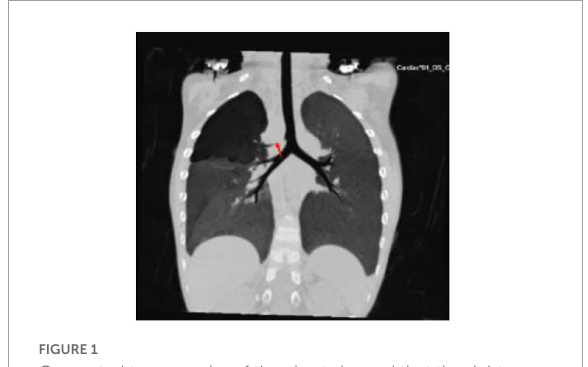
FIGURE1 Computed tomography of the chest showed that the right upper lung had enhanced transmittance due to the right tracheal bronchus’ oppression (arrow).